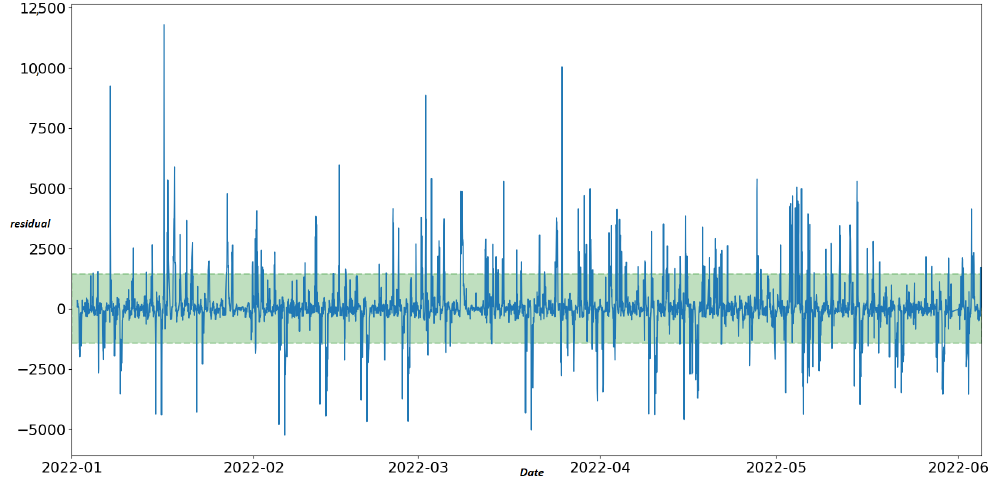
Figure 5. Residual curve of sensor “MS734” with the upper and lower fences of the IQR method. The green dots represent unusual traffic conditions. Red dots represent sensor faults.